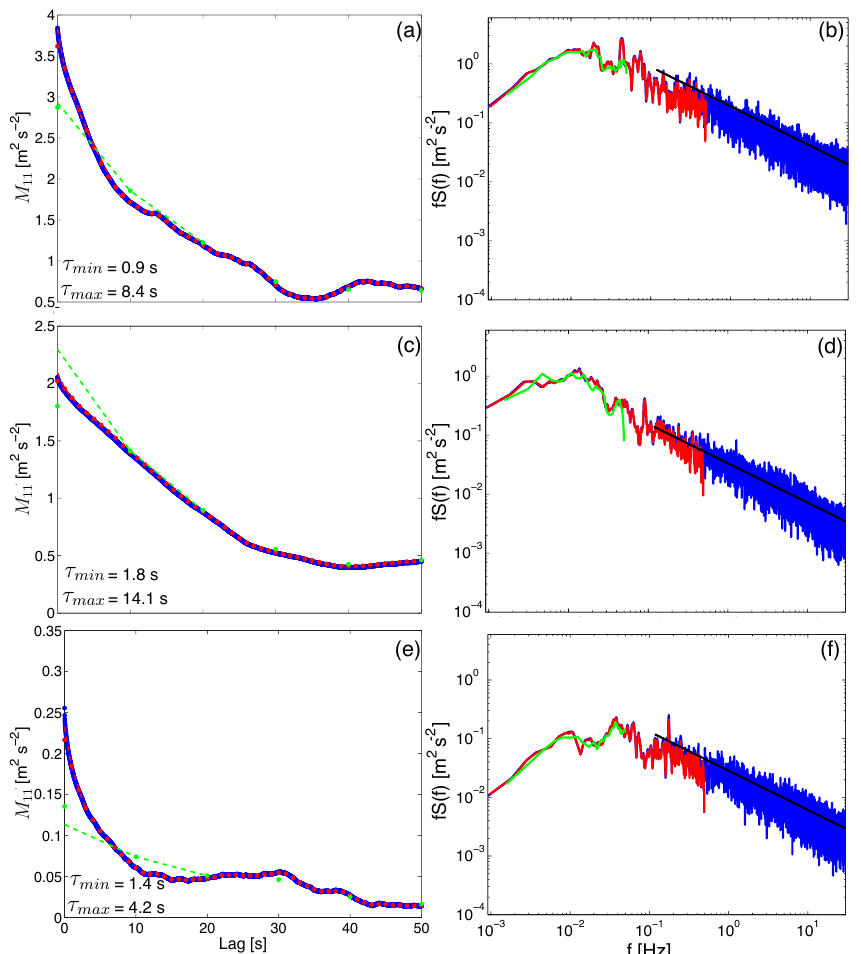
Figure 5. (a, c, e) Sample M 11 from the 300m 60Hz sonic data (blue dots) compared with the sonic data averaged to 1Hz (red dots) and 0.1Hz (green dots). Dashed lines are the fittings of Eq. (4) to the filtered sonic data, using the specified number of lags discussed in Sect. 3.2. Corresponding spectra are shown in (b, d, f) , with the black solid line denoting the theoretical − 2/3 slope in the inertial subrange. M 11 and the spectra are calculated over 02:00–02:30UTC (a, b) , 20:30–21:00UTC (c, d) , and 01:00–01:30UTC (e, f) all on 27 March. Values of τ min and τ max are provided in the lower left. Spectra are smoothed for clarity using a 5-point moving average.